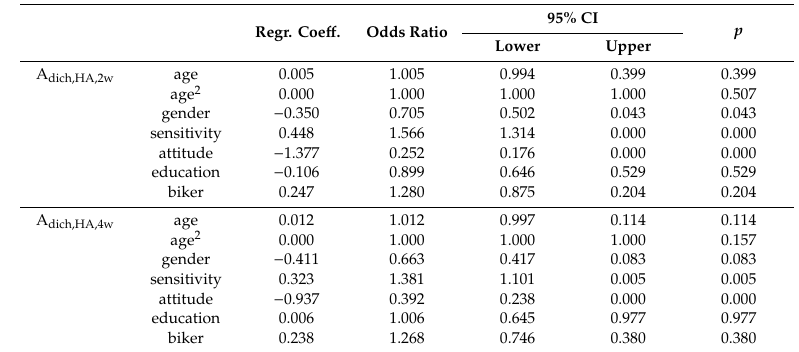
Table 6. Univariate correlation of highly annoyed from 2-wheelers and 4-wheelers with other characteristics.